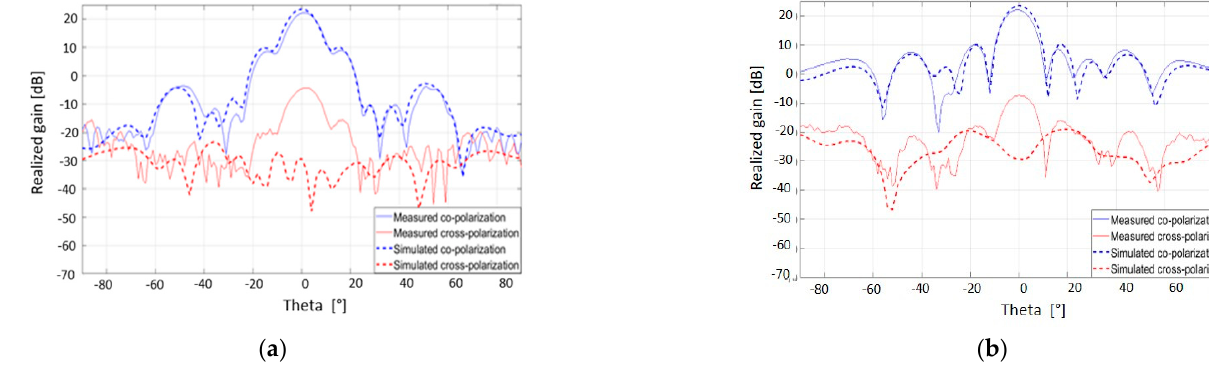
Figure 15. Radiation pattern (gain) of the SWA: comparison of simulated and measured co- and cross-polarization at 15 GHz. ( a ) E-plane pattern and ( b ) H-plane pattern .